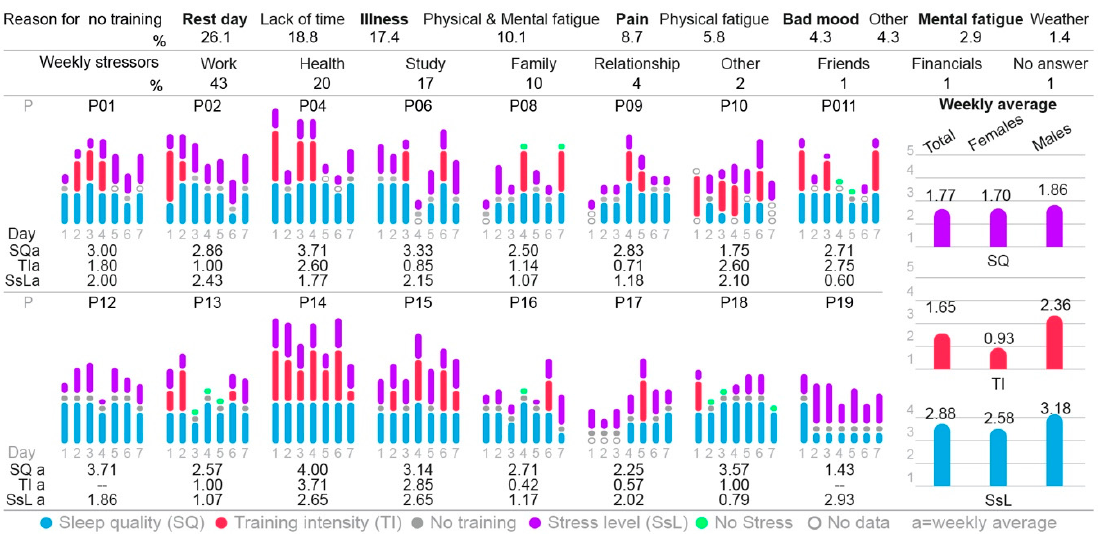
Figure 3. Results overview: visualization of the heterogeneity and diversity of participants’ daily life in terms of sleep quality perception, training behavior, training intensity perception, and psychosocial stress